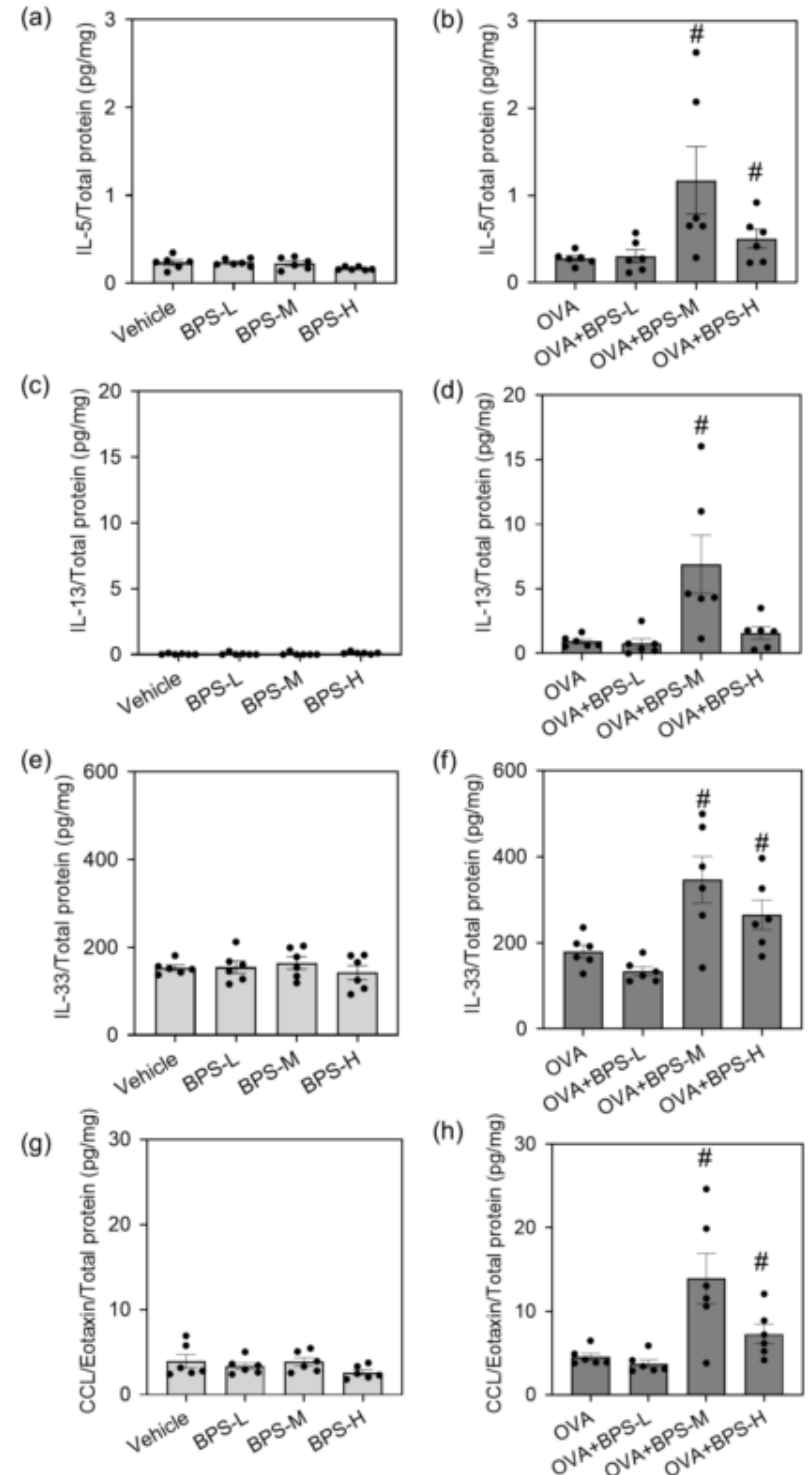
Figure 6. Protein levels of cytokines and chemokines in the lung. Protein levels in the lung homogenate supernatants were measured 48 h after the last intratracheal administration by ELISA. ( a , b ) IL-5. ( c , d ) IL-13. ( e , f ) IL-33. ( g , h ) CCL11/Eotaxin. The abundance of the target protein was normalized to the total amount of protein. Data are expressed as mean ± SE for 5–6 animals per group. # p < 0.05 vs. OVA group. ELISA, enzyme-linked immunosorbent assay; IL, interleukin; OVA, ovalbumin; SE, standard error.